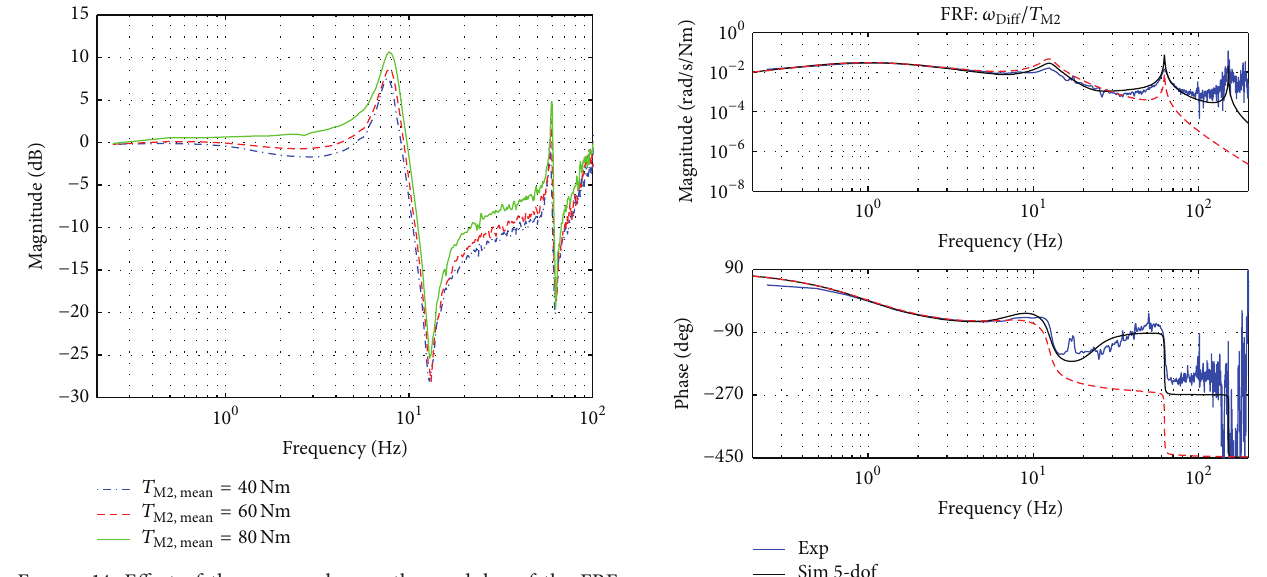
Figure 14: Effect of the mean value on the modulus of the FRF 𝑇 𝑇 fb ,5 / ref ,5 .